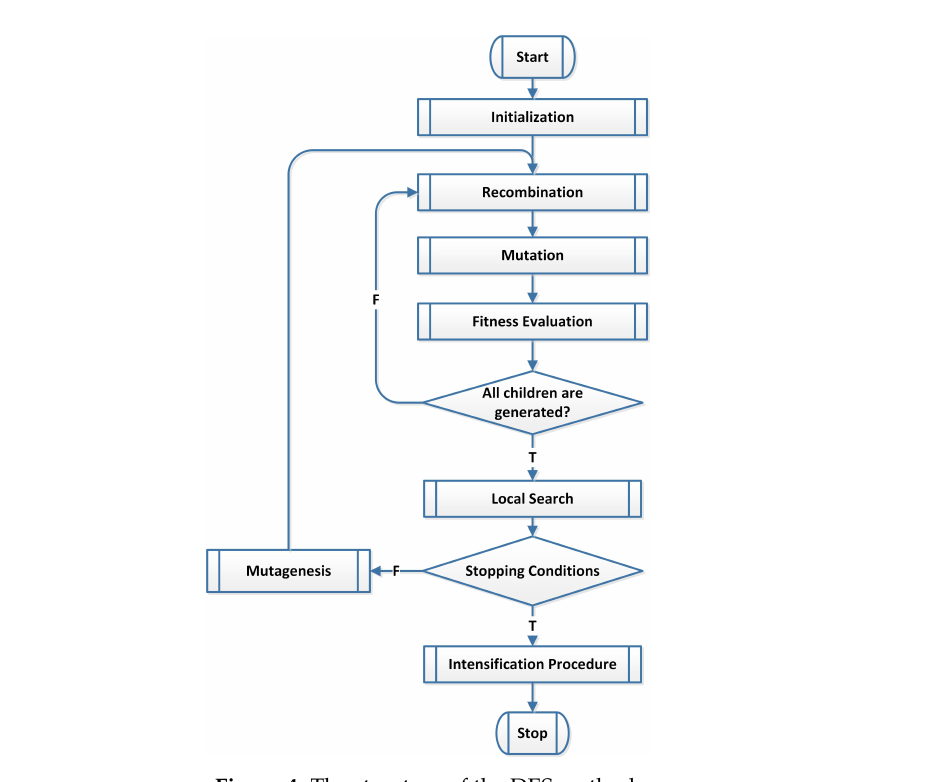
Figure 4. The structure of the DES